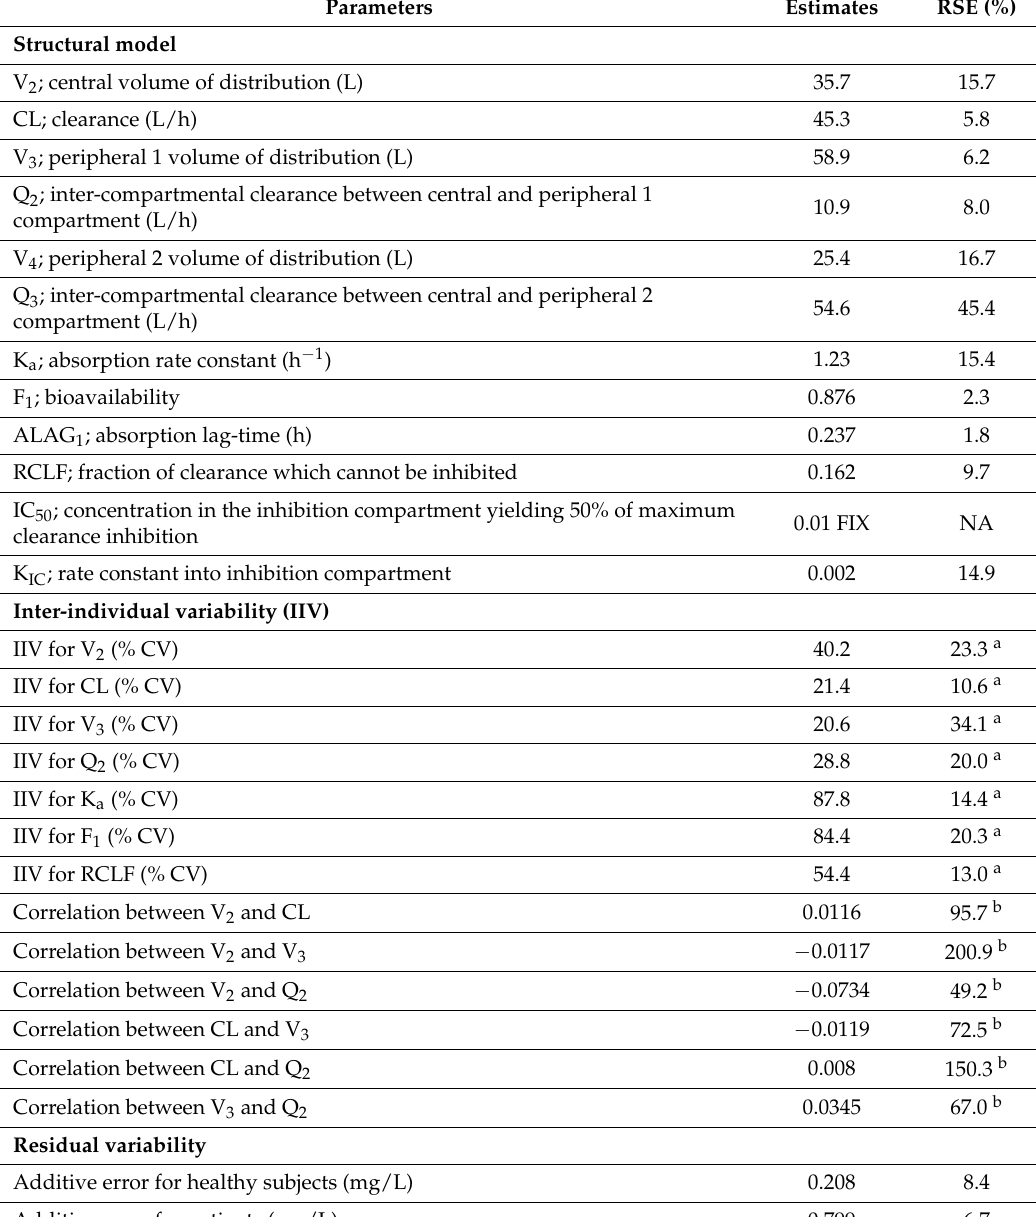
Table 2. Parameter estimates of the final population pharmacokinetic